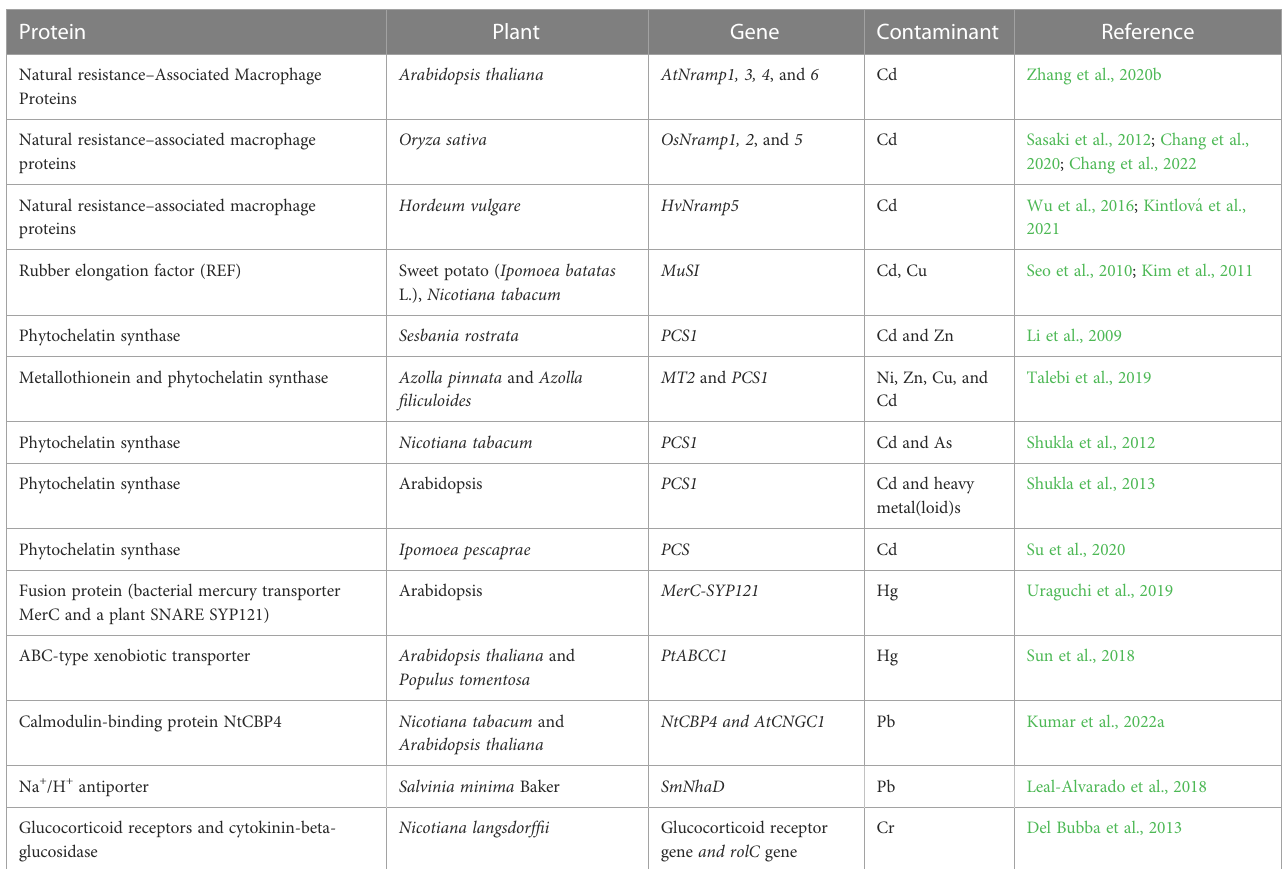
TABLE 2 Plant proteins and respective genes in the phytoremediation of heavy